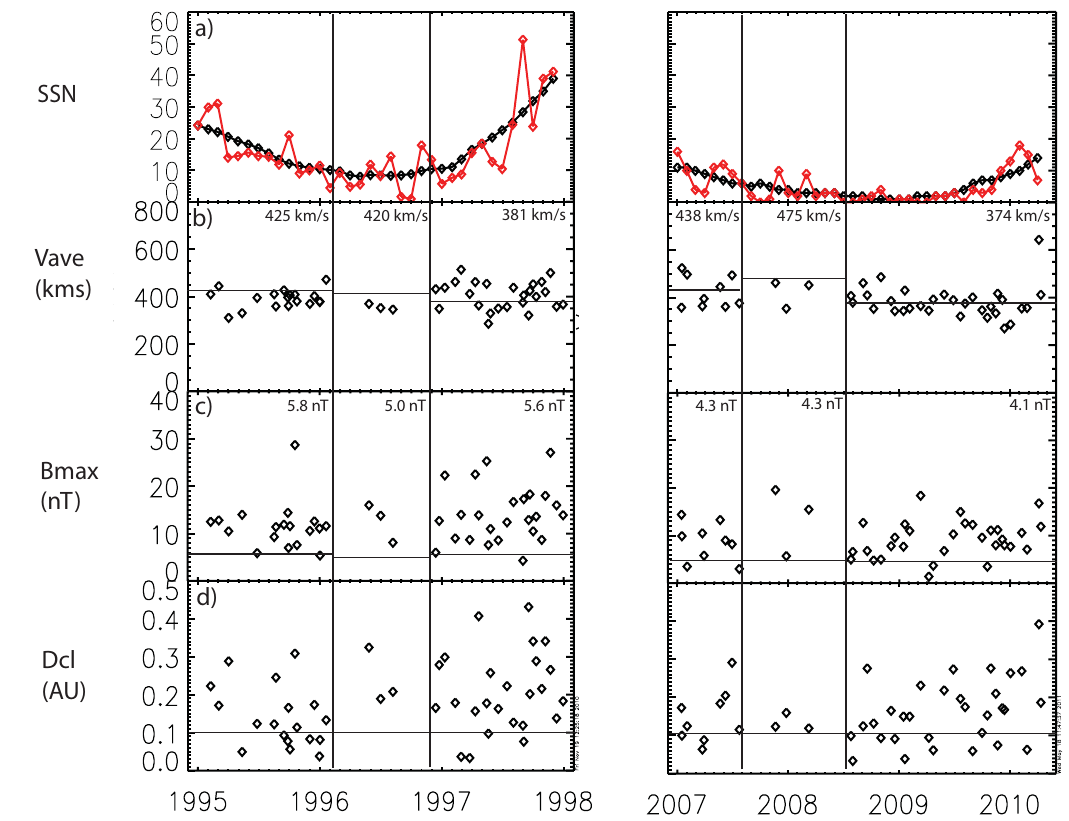
Fig. 3. ICME parameters for the SC 22 (left) and SC 23 (right) minima as a function of time. The panels show from top to bottom: (a) monthly (red) and smoothed (black) monthly sunspot numbers from the Solar Influences Data Center, (b) average solar wind speed, (c) maximum magnetic field, and (d) radial width for each ICME. The period of the lowest ICME rate is bounded between two vertical lines (see Sect. 3.1 and Fig. 2). In panels (b) and (d) the mean solar wind speeds and magnetic field magnitudes averaged over the time periods before, during and after the ICME rate minimum are indicated with horizontal lines and the corresponding values are given above. In panel (d) the horizontal line shows the radial width